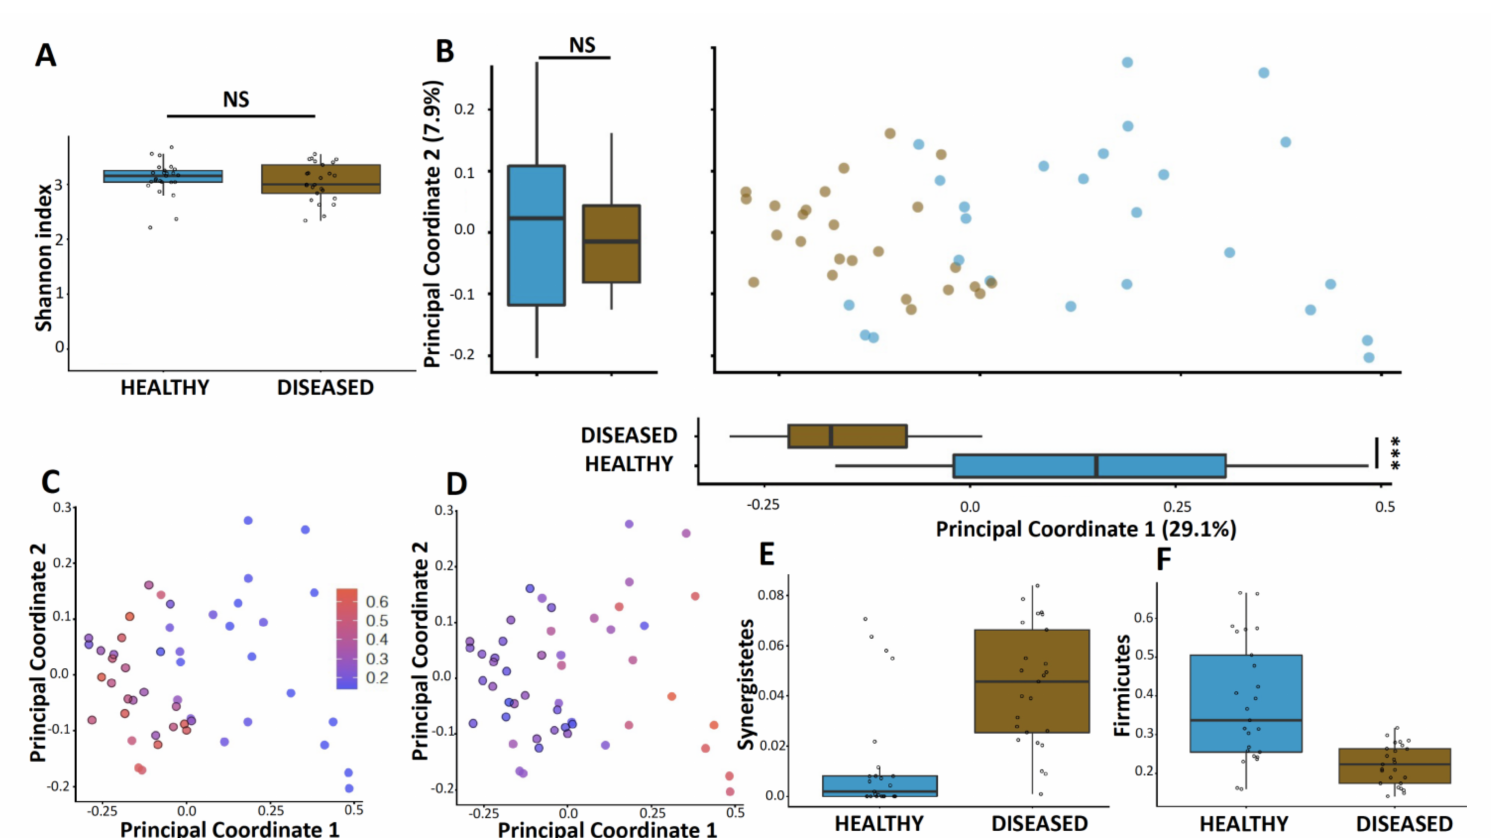
Figure 1. Microbiome diversity is altered in periodontitis sites compared to healthy sites. ( A ) Alpha diversity of periodontitis sites and healthy sites, depicted by the Shannon index, compared by the use of Mann-Whitney U test. ( B ) Principal-coordinate analysis of unweighted UniFrac distances for periodontitis sites and healthy sites. Box plots shown along each axis represent the median and interquartile range and indicate the distribution of samples along the given axis. Each point represents a single sample and is colored by site. PERMANOVA values, R2 values, and p values are shown. The same principal-coordinate analysis colored by the relative abundances of phyla, ***: p < 0.001 ( C ) Synergistetes and ( D ) Firmicutes. Relative abundances of phyla ( E ) Synergistetes and ( F ) Firmicutes within the periodontitis sites and the healthy sites, as assessed by Mann-Whitney tests with false-discovery-rate